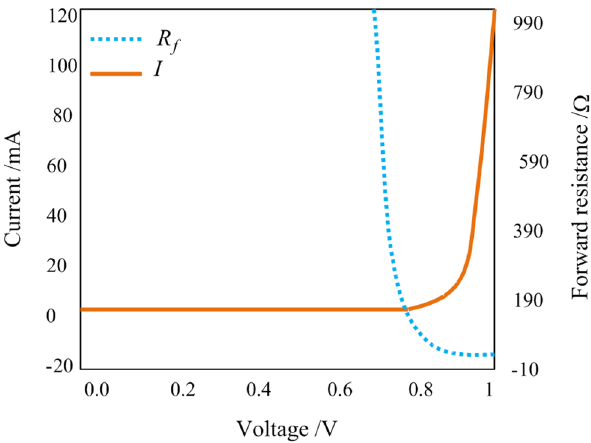
Fig 4. I-V characteristic and forward resistance changing